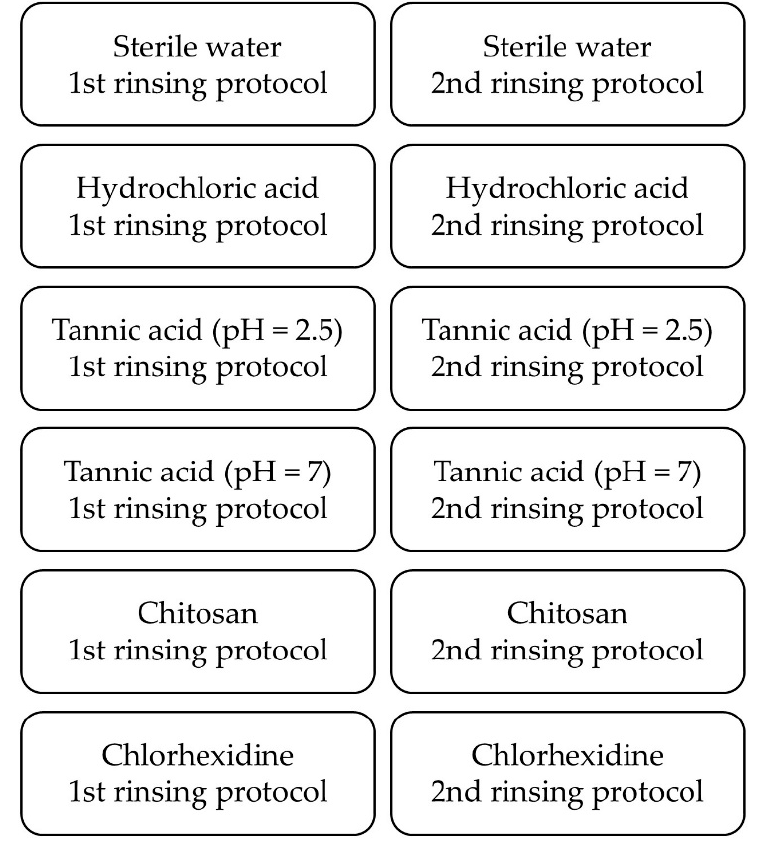
Figure 2. Rinsing sequences every subject has to go through. In each round, one test substance was applied according to one rinsing protocol.